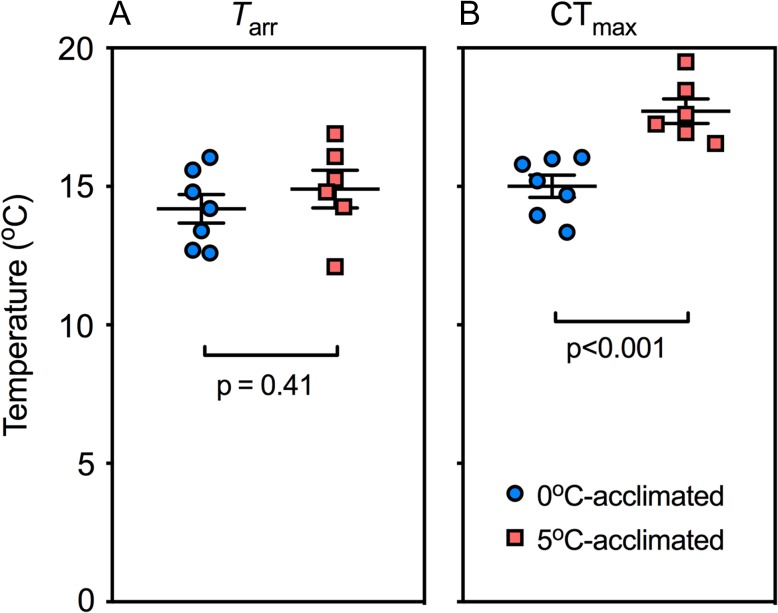
The effects of 0 and 5°C acclimation (6–9.5 weeks) on the temperature at which cardiac arrhythmia develops (Tarr) and complete cardiac failure (CTmax) occurs during an acute thermal challenge. Significant differences were evaluated with unpaired t-tests (P < 0.05). Data are mean ± SEM and individual data points